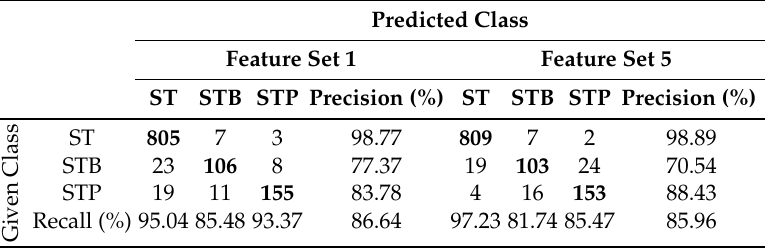
Table 12. Confusion metrics for fs1 and fs5 at the LH position achieved through KNN.